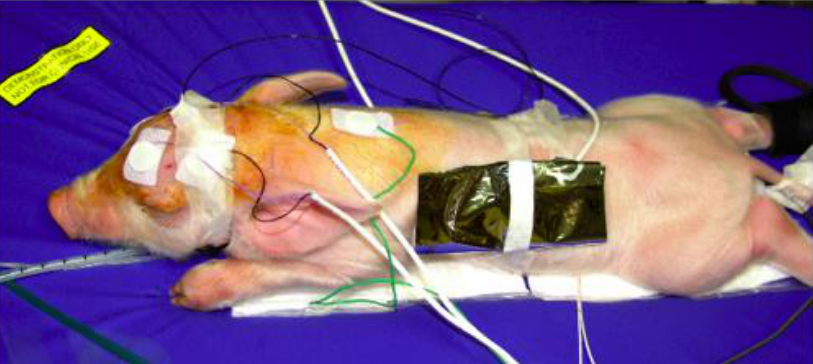
Figure 7. An asphyxia piglet on a PCM 32 mattress with a gel mattress cover continuously cooled to 33.5 °C. From a study Iwata et al. [45].